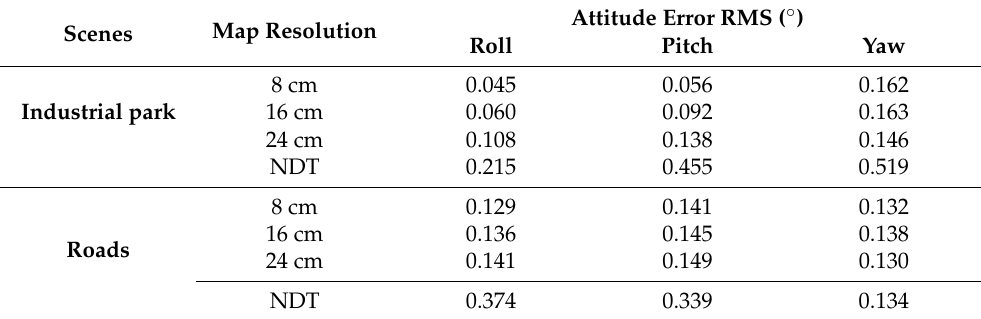
Table 4. The RMS of attitude error using different map resolution in different scenes.